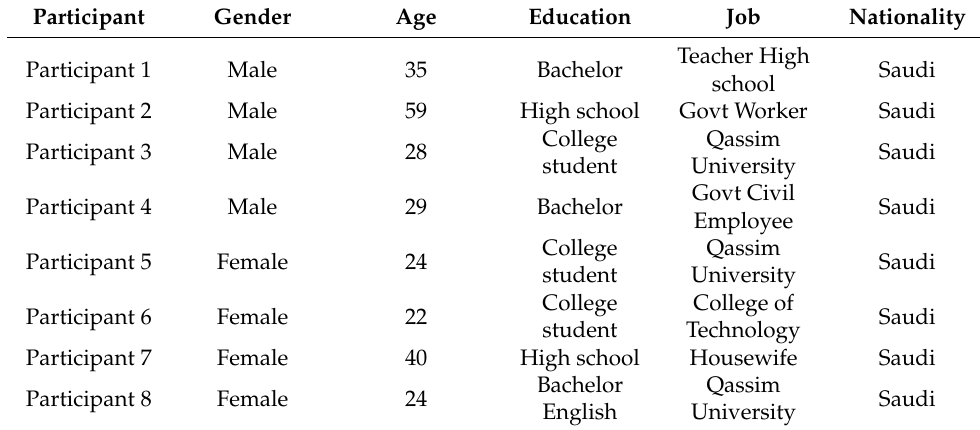
Table 2. Demographic Characteristics of the Participants.